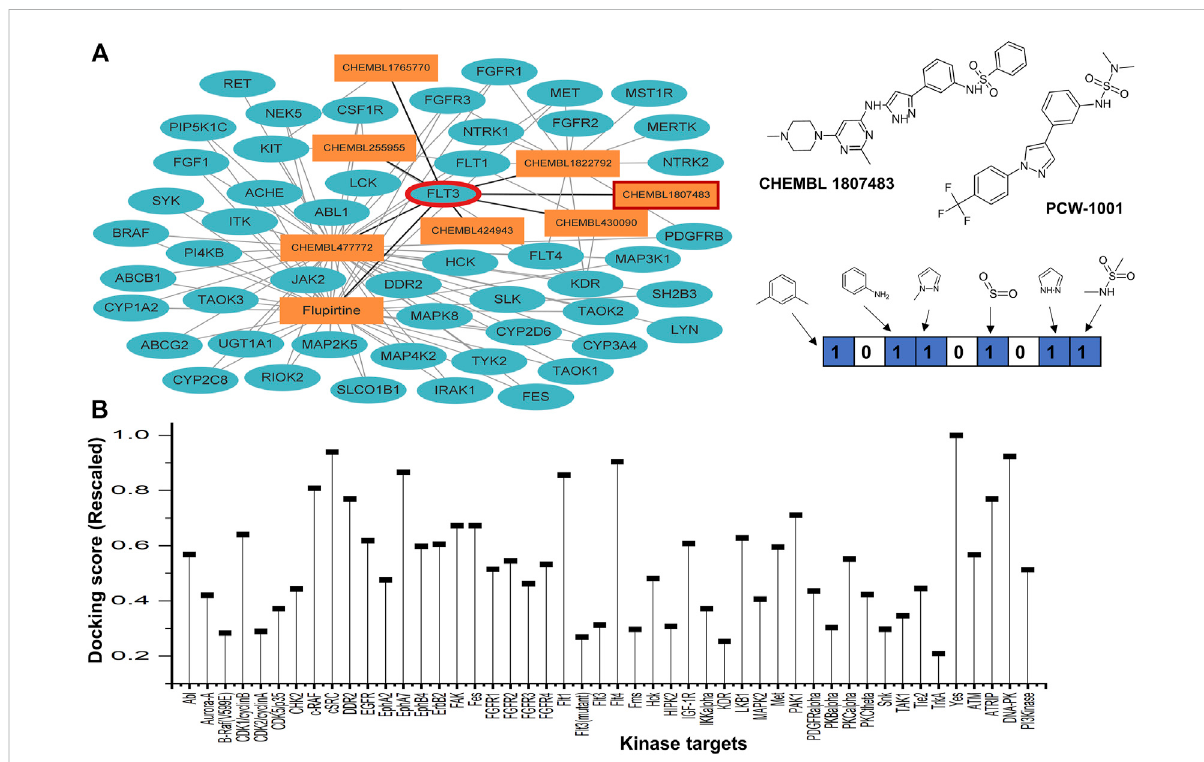
FIGURE 2 Network-based reverse target prediction. (A) Protein-Ligand interaction network with nodes (depicted in dark turquoise elliptical sphere) as proteinsandedges(rectangularorangebox)asligandsobtainedfromChEMBL,DrugBankandPubChem.Tanimotosimilarityidenti fi edusingMACCS keys fi ngerprint between query compound (PCW-A1001) and the top hit CHEMBL 1807483 (shows interactions with FLT3) is 0.67. (B) Study of selectivity of the PCW-1001 against the panel of 48 representative kinase enzymes. The score was rescaled to be ranged, as the lower value corresponds to more energetically favorable